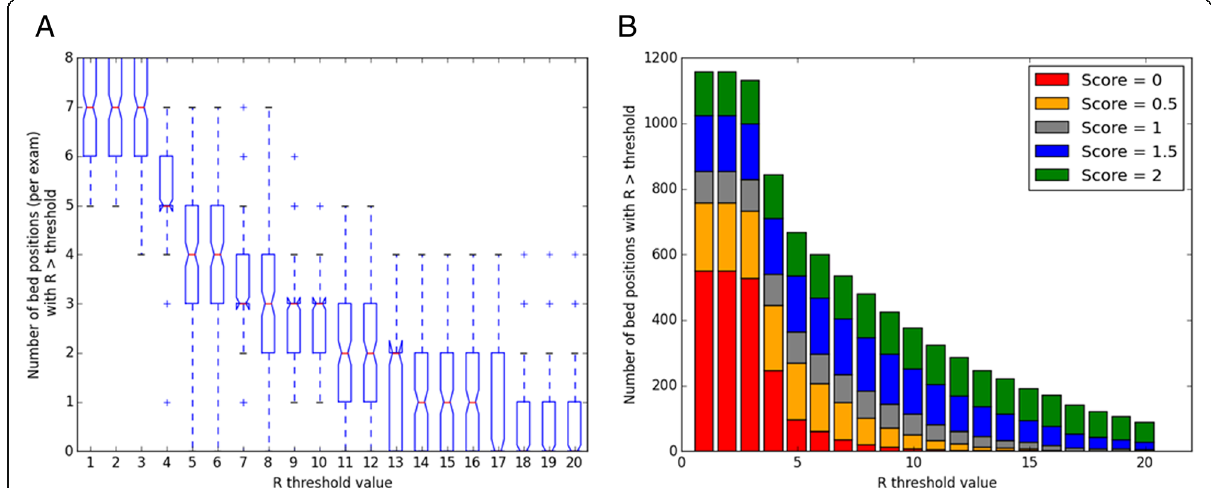
Fig. 4 a Number of bed positions per patient with R greater than a set threshold, shown for R value thresholds between 1 and 20. b Total number of bed positions with R greater than the R value threshold, split by the score S assigned to the waveform from visual inspection of all bed positions in 157 examinations. Shown for R value thresholds between 1 and 20. For data in both figures, the acquisition duration per bed position was 240 s (4 min)